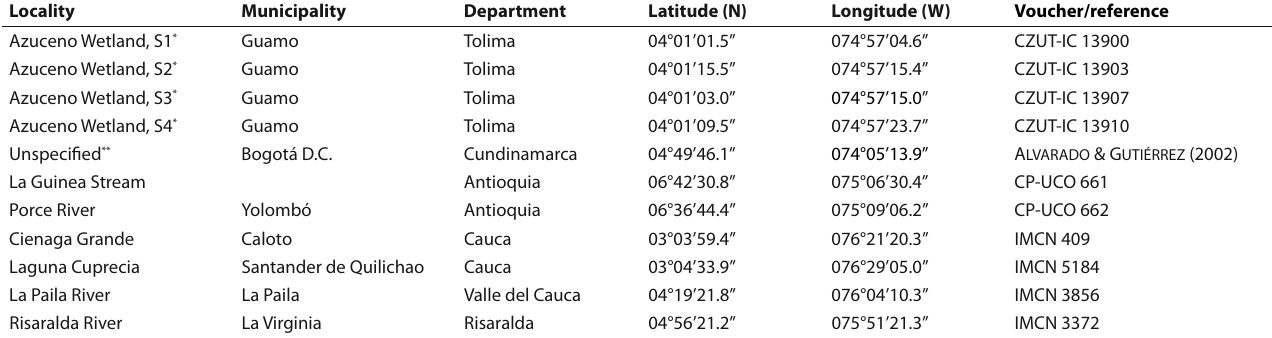
Table 3. Records of X. maculatus in Colombia. Asterisk = new report, double asterisk = bibliographic report with approximate coordinates.